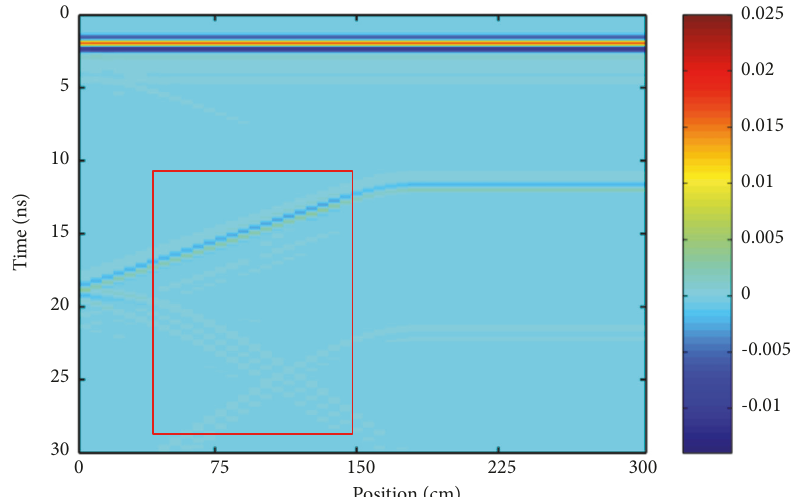
Figure 13: The wiggle trace profile of the embankment model simulated by the CUDA-implemented nonconformal SPRK methods.